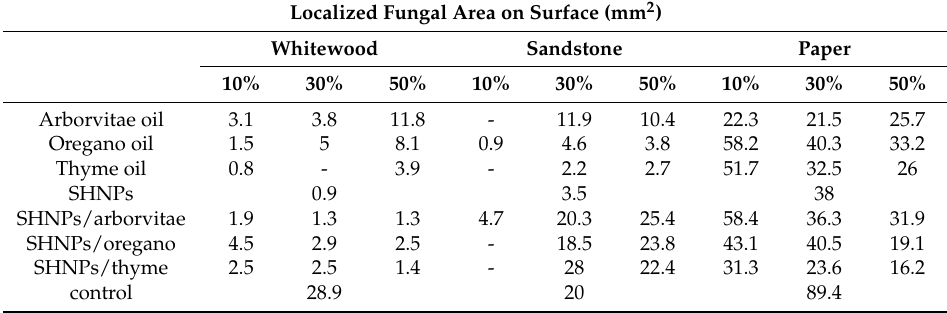
Table 3. The growth area of fungi on assayed